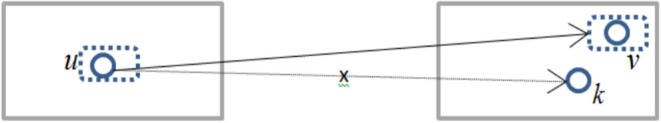
Area constraint diagram.